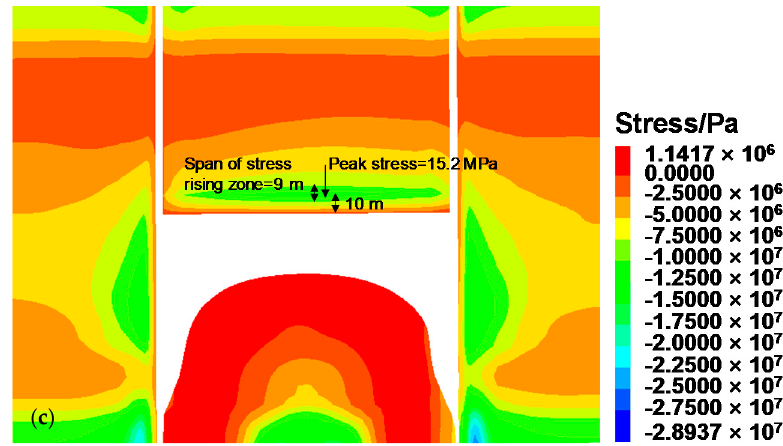
Figure 14. Horizontal stress distribution in front and side of the working face under the three mining modes. ( a ) Large pillar mining; ( b ) Small pillar mining; ( c ) Non-pillar mining.